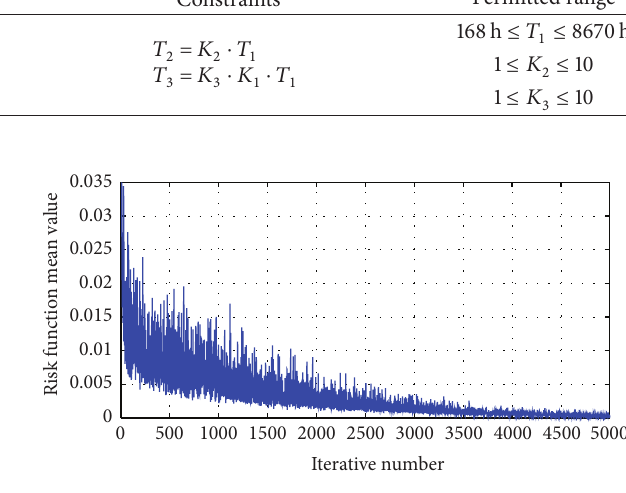
Figure 4: Convergence evolution versus risk function.